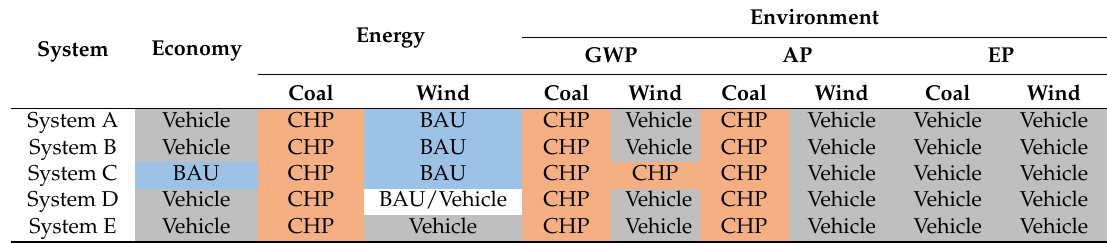
Table 3. The most preferred scenario in the different systems for each